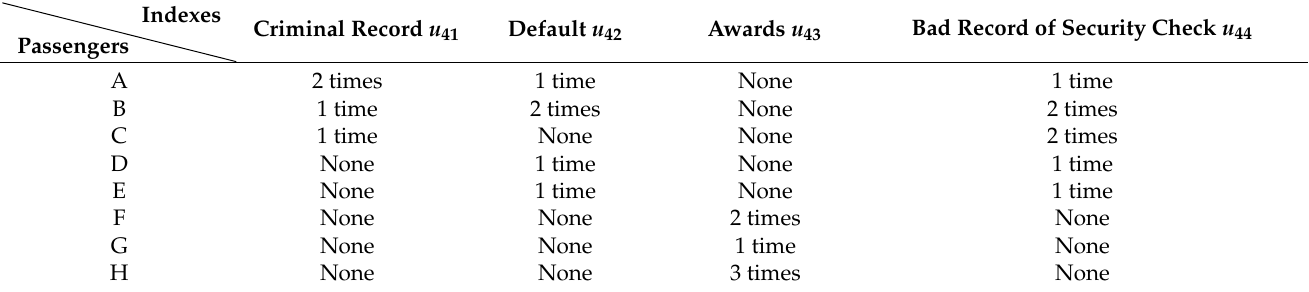
Table 17. Sample data of passengers (personal conduct indexes).